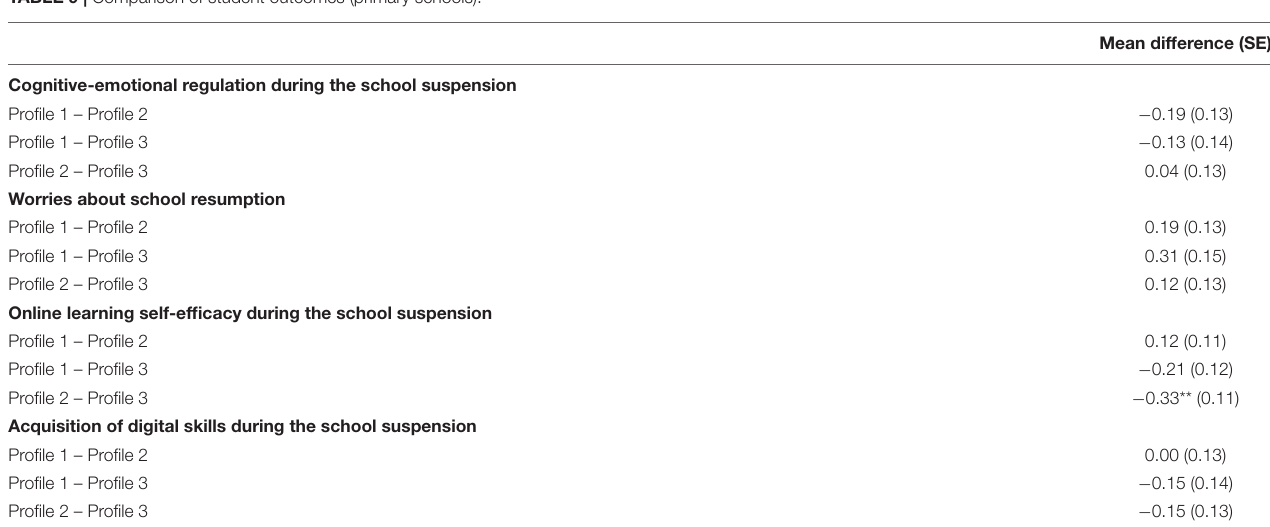
TABLE 9 | Comparison of student outcomes (primary